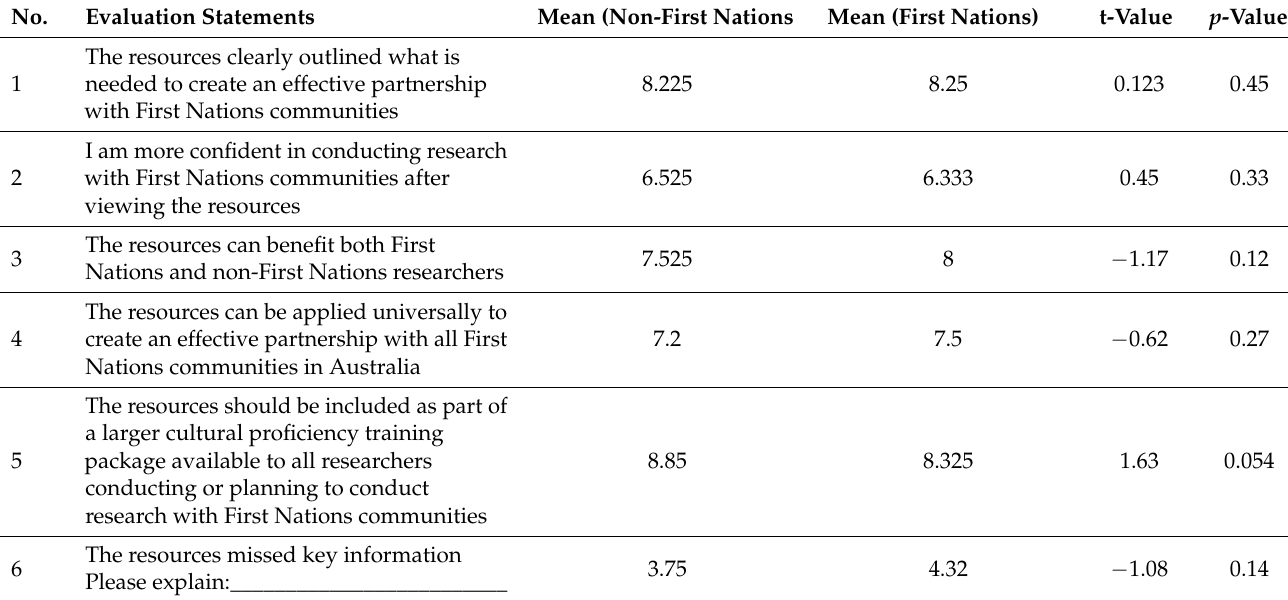
Table 2. Online Resource Evaluation Results (video and